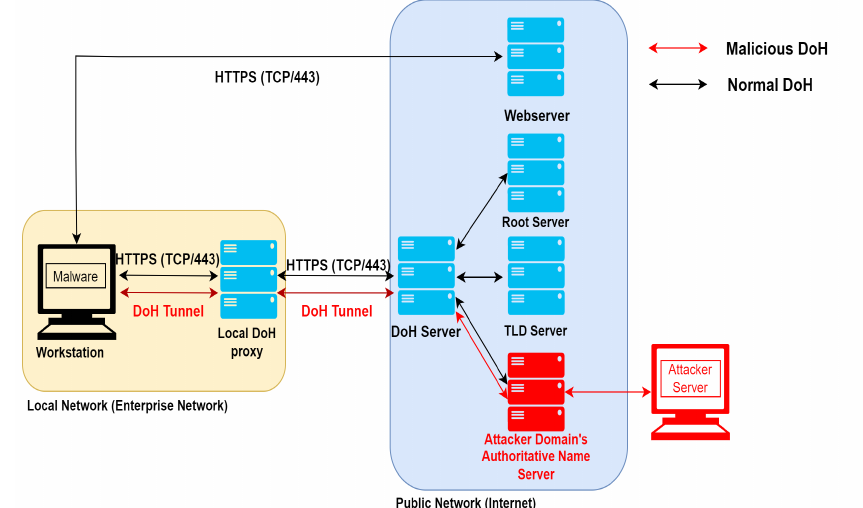
Figure 3. DoH tunneling attack